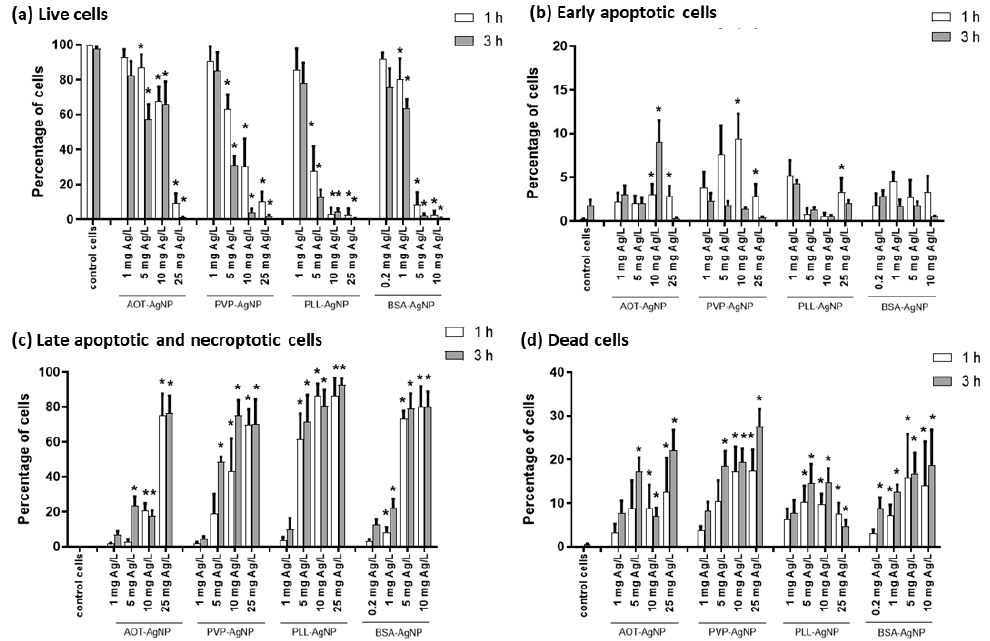
Figure 3. The effect of AOT-AgNPs, PVP-AgNPs, PLL-AgNPs, and BSA-AgNPs on the % of ( a ) live cells, ( b ) early apoptotic cells, ( c ) late apoptotic, necroptotic and secondary necrotic cells, and ( d ) dead cells, as determined by flow cytometry after Annexin V/PI staining. The hPBMC were exposed to AgNPs for 1 h (white columns) and 3 h (grey columns). Controls were untreated cells. The results are expressed as percentage of controls and given as mean values obtained from six independent experiments including SD as error bars. Values marked with asterisk (*) differ significantly from the negative control ( p < 0.05).